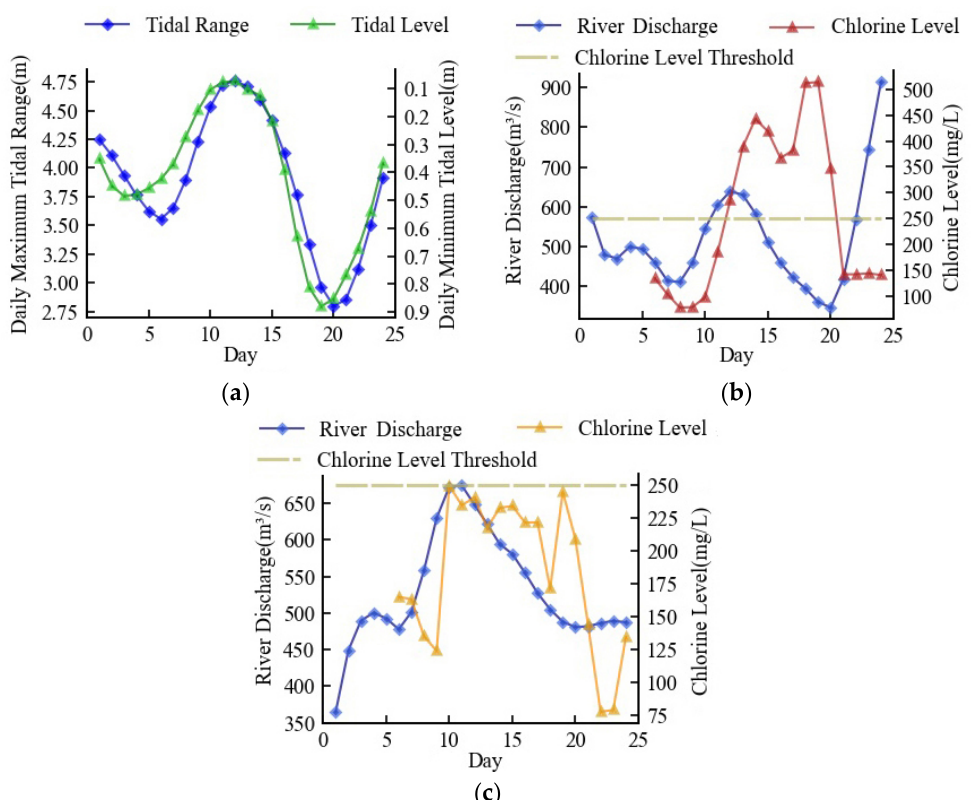
Figure 10. Minimum discharge scheme in the third tide scenario: ( a ) measured tide; ( b ) measured river discharge and chlorine level; ( c ) optimized river discharge and simulated chlorine level.